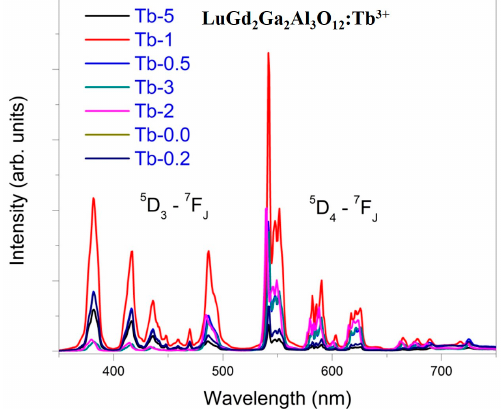
Figure 6. X-ray induced Emission spectra of LuGd 2 Ga 2 Al 3 O 12 :Tb 3+ phosphor.